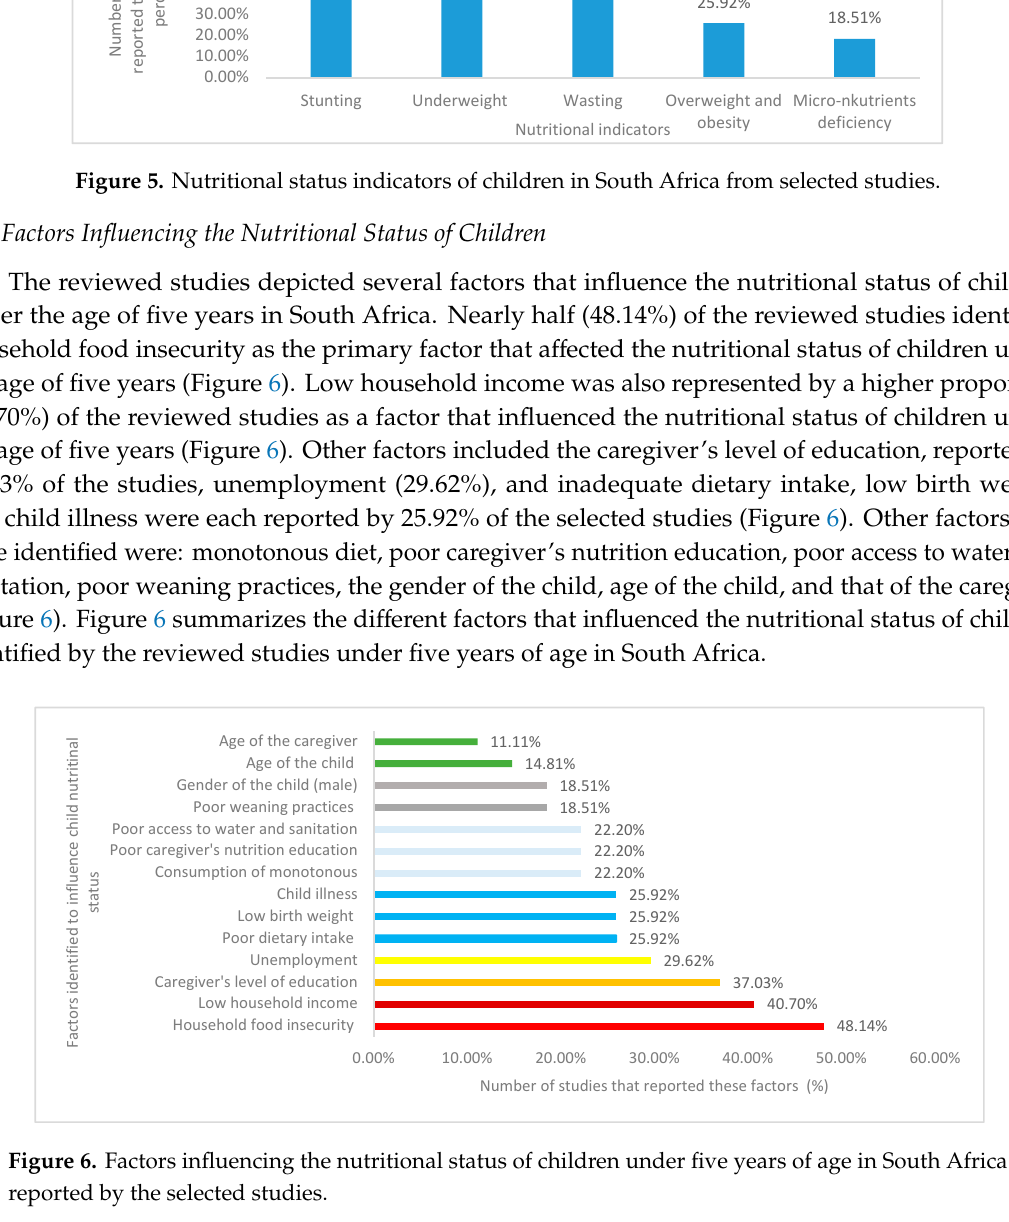
Figure 5. Nutritional status indicators of children in South Africa from selected studies.